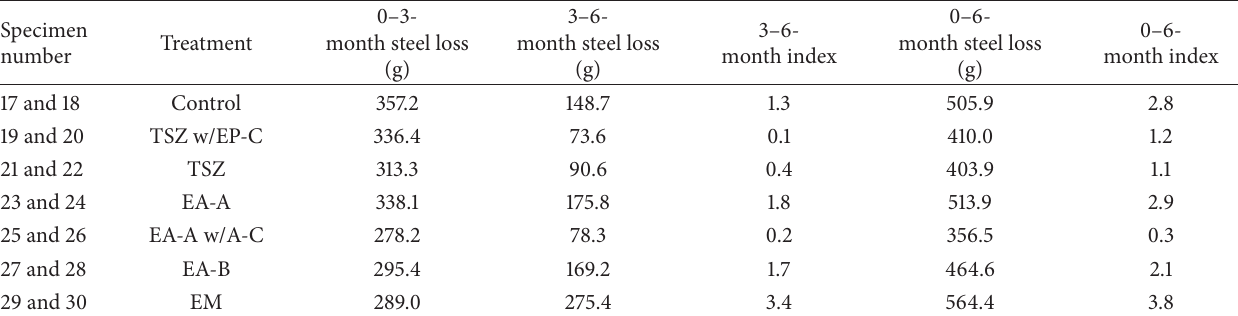
Table 3: Steel loss of CoC specimens after 3-month exposure and 6-month exposure.